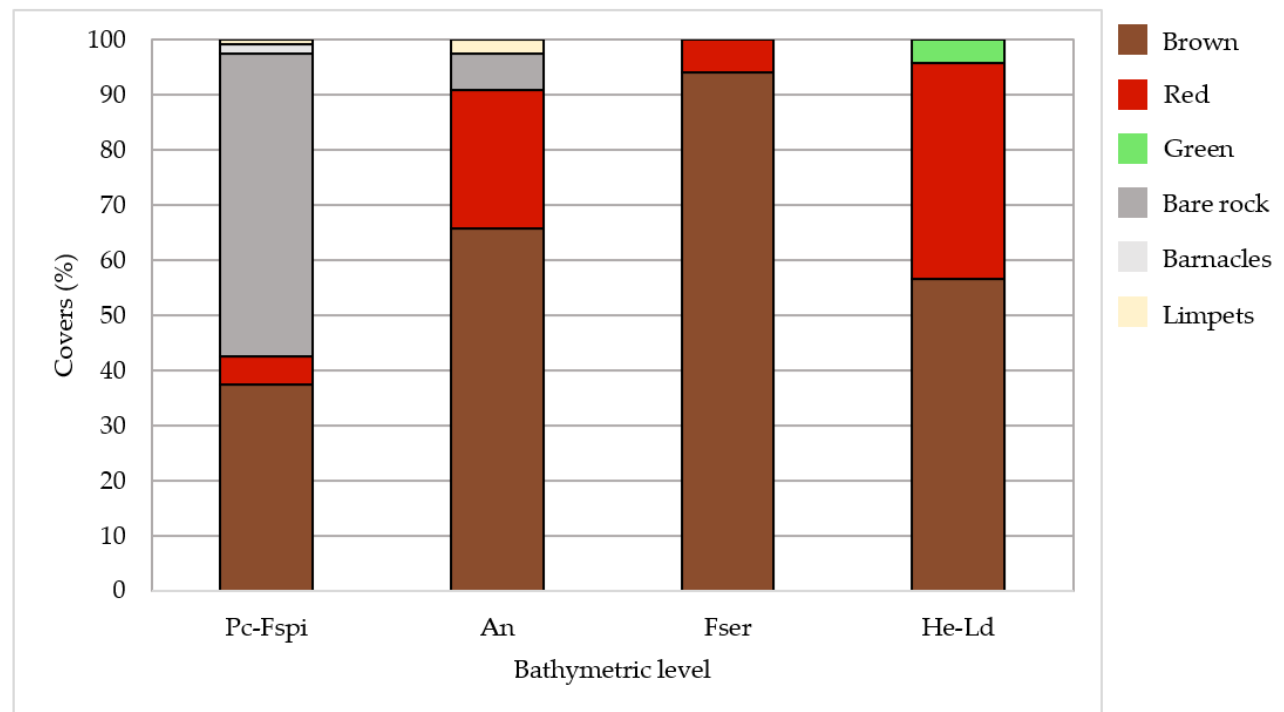
Figure 5. Average covers of macroalgal groups and sessile fauna, and percentage of bare rock observed in situ at each bathymetric level. Covers are given in percentages. Fucoids and other brown species are grouped in the ‘Brown’ class, and erect and crustose red algae are grouped in the ‘Red’ class.